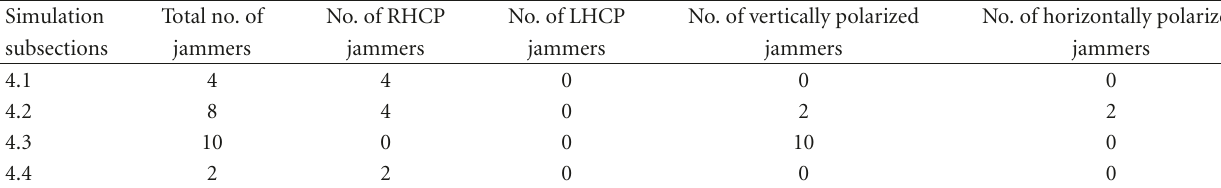
Table 1: Summary of the simulation parameters.